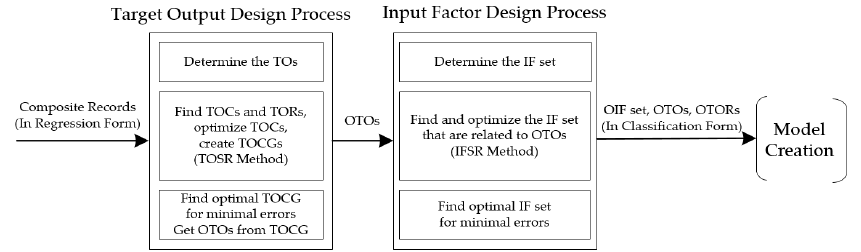
Figure 7. Conceptual framework of the feature extraction process (TO = Target Output, TOR = TO Relationship, TOC = TO Cluster, TOCG = TOC Group, IF = Input